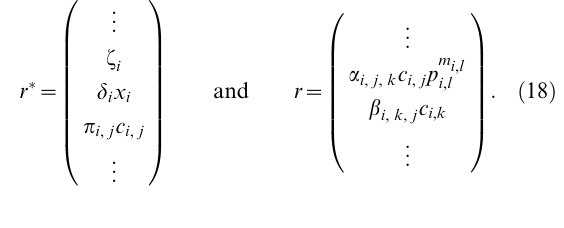
Parameter Symbol Range Unit Reference Production rate constant